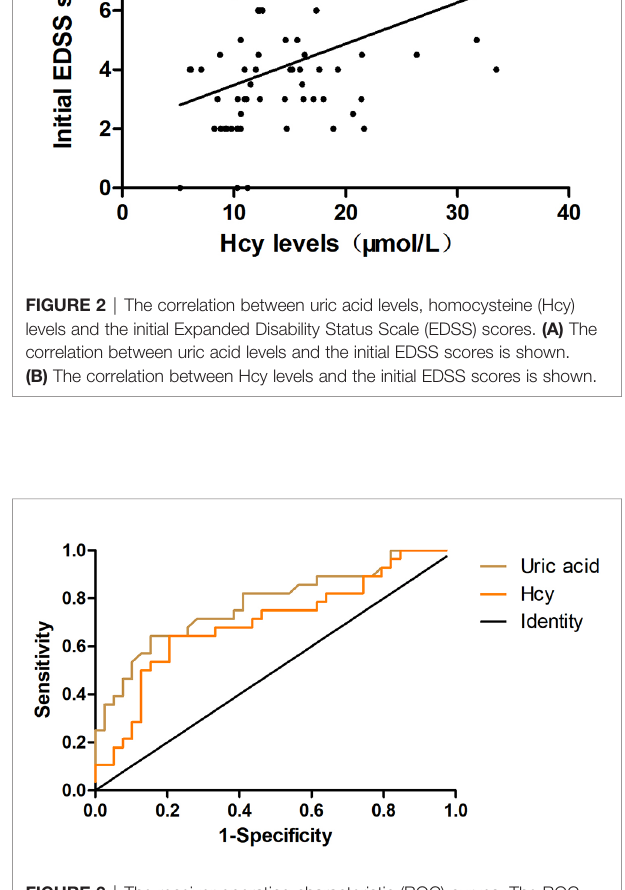
FIGURE 3 | The receiver operating characteristic (ROC) curves. The ROC curves show the predictive abilities of uric acid (light brown) and serum homocysteine (orange) for the severity of neurological dysfunction at the onset of myelin oligodendrocyte glycoprotein antibody disease